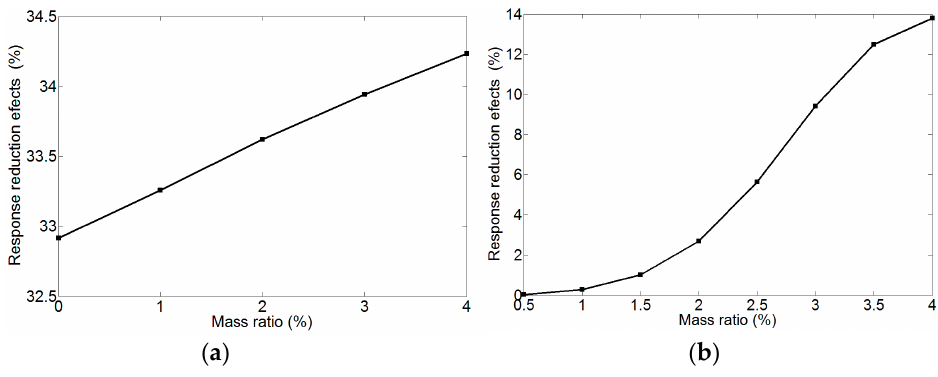
Figure 12. The influence of the mass ratio: ( a ) Maximum acceleration; ( b ) r.m.s acceleration.